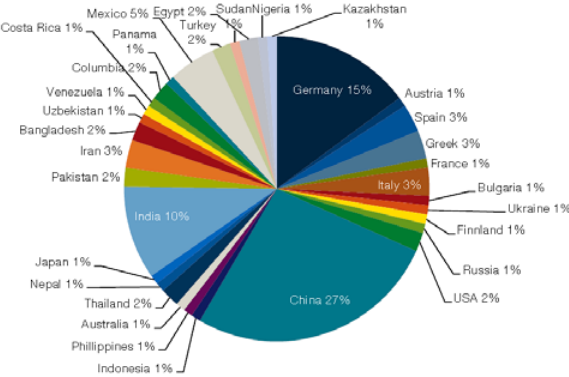
Figure 3. Countries of origin of ESPACE